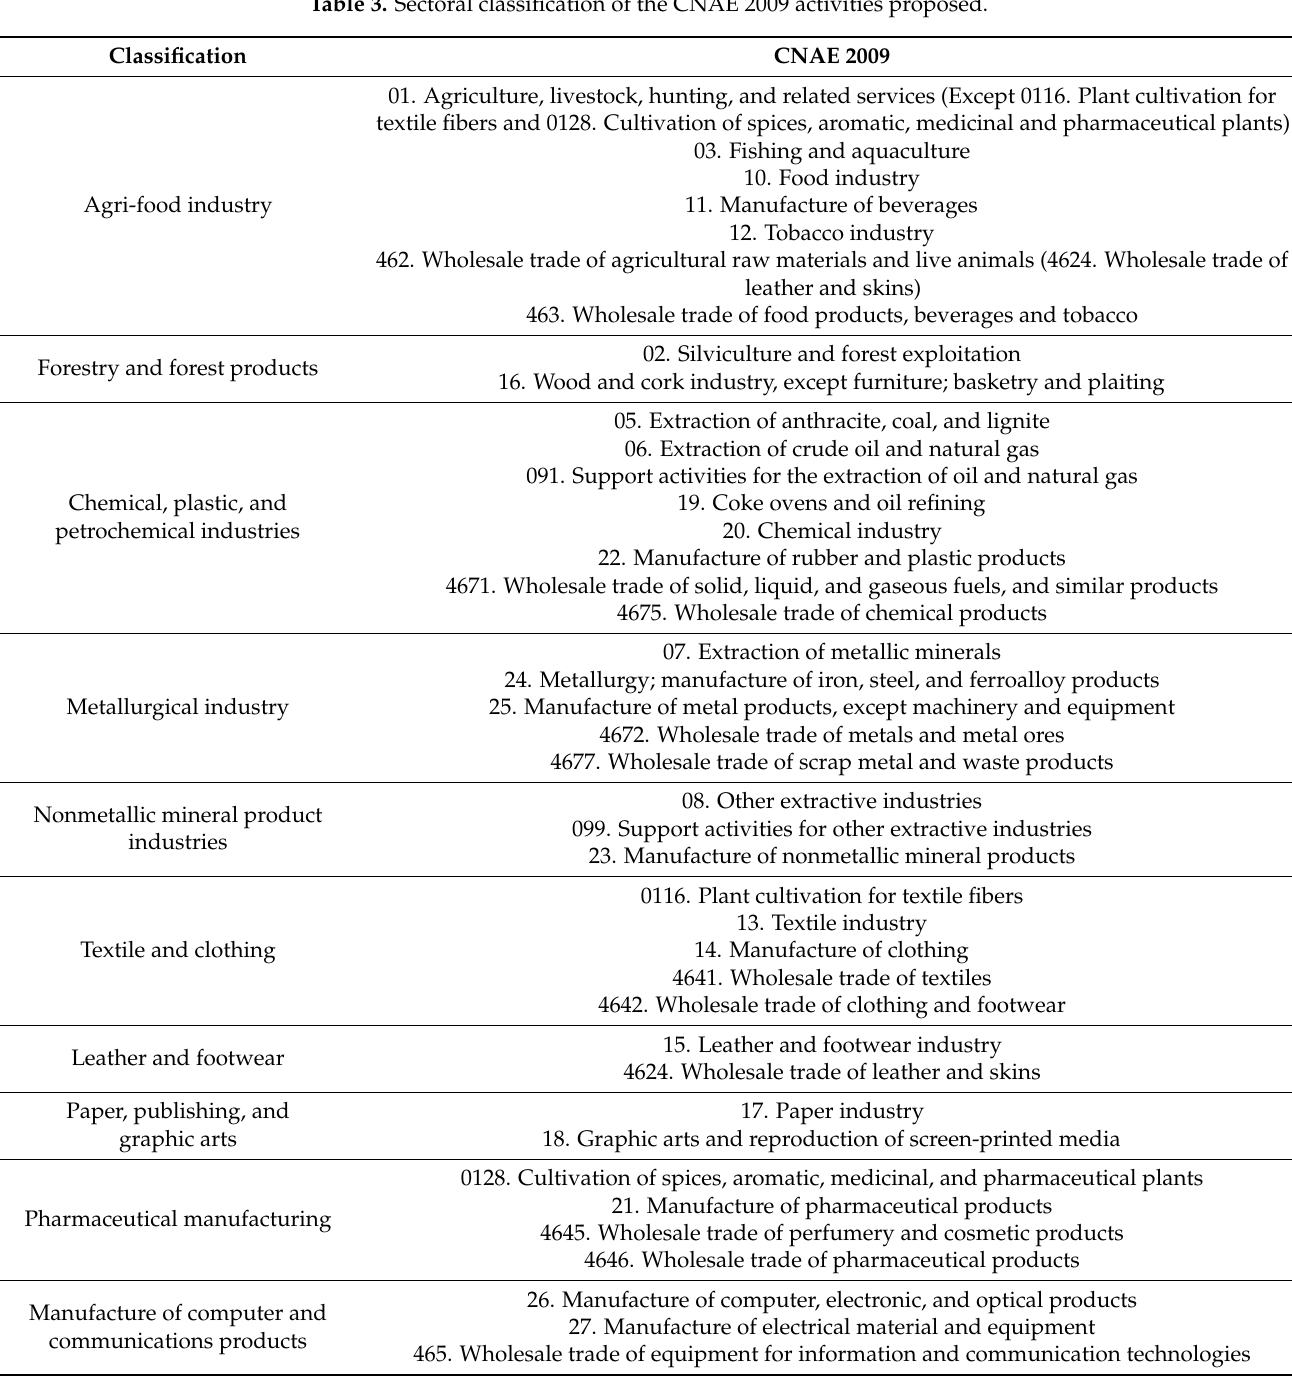
Table 3. Sectoral classification of the CNAE 2009 activities